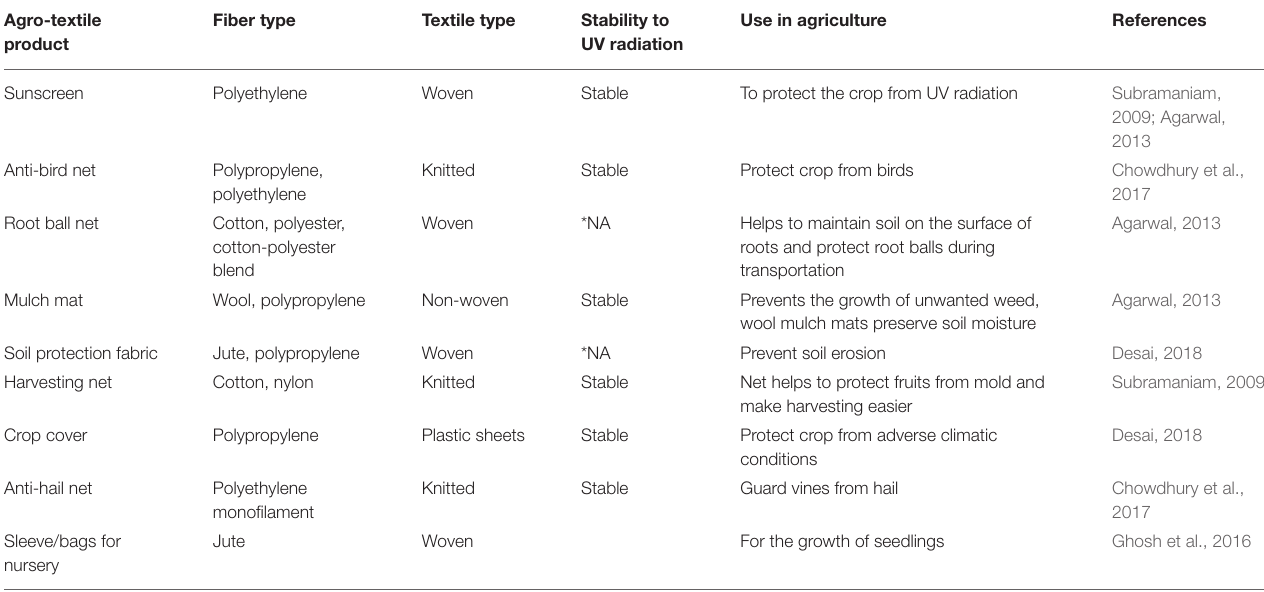
TABLE 4 | Applications of agro-textile products in